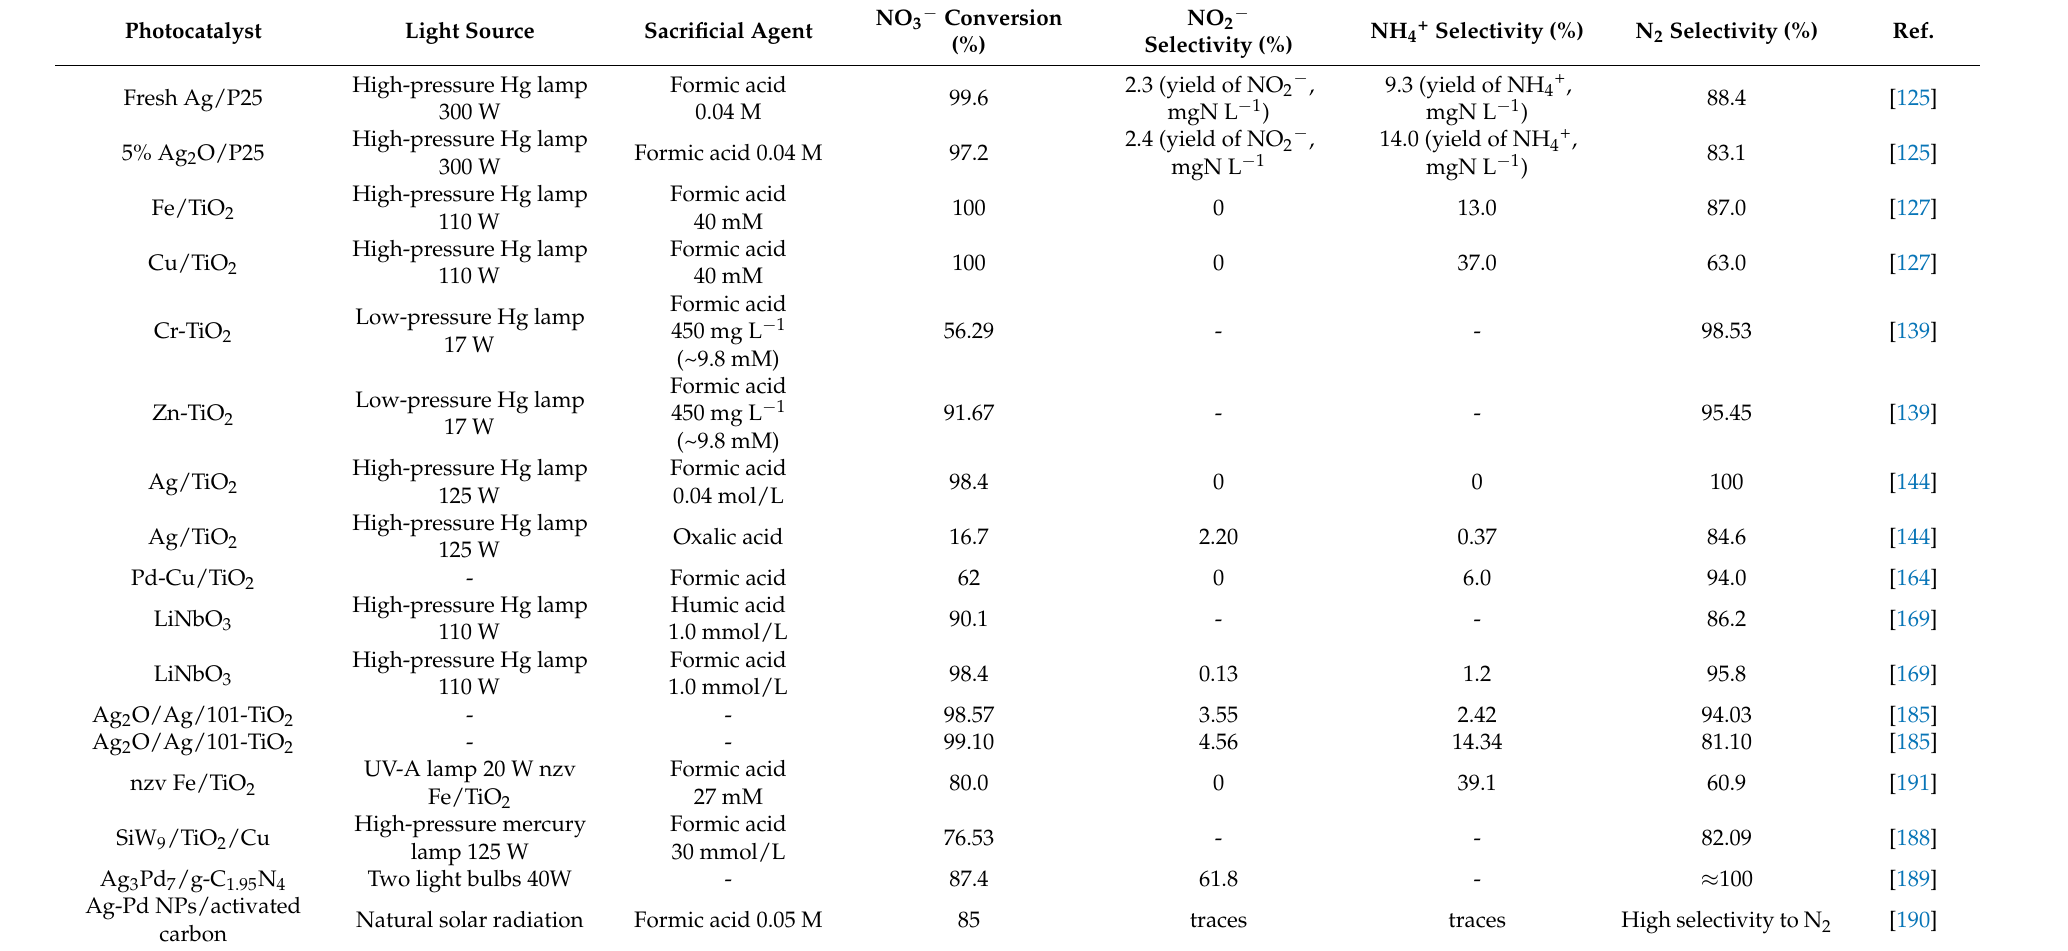
Table 4. Comparative results of the photocatalytic performance obtained on different